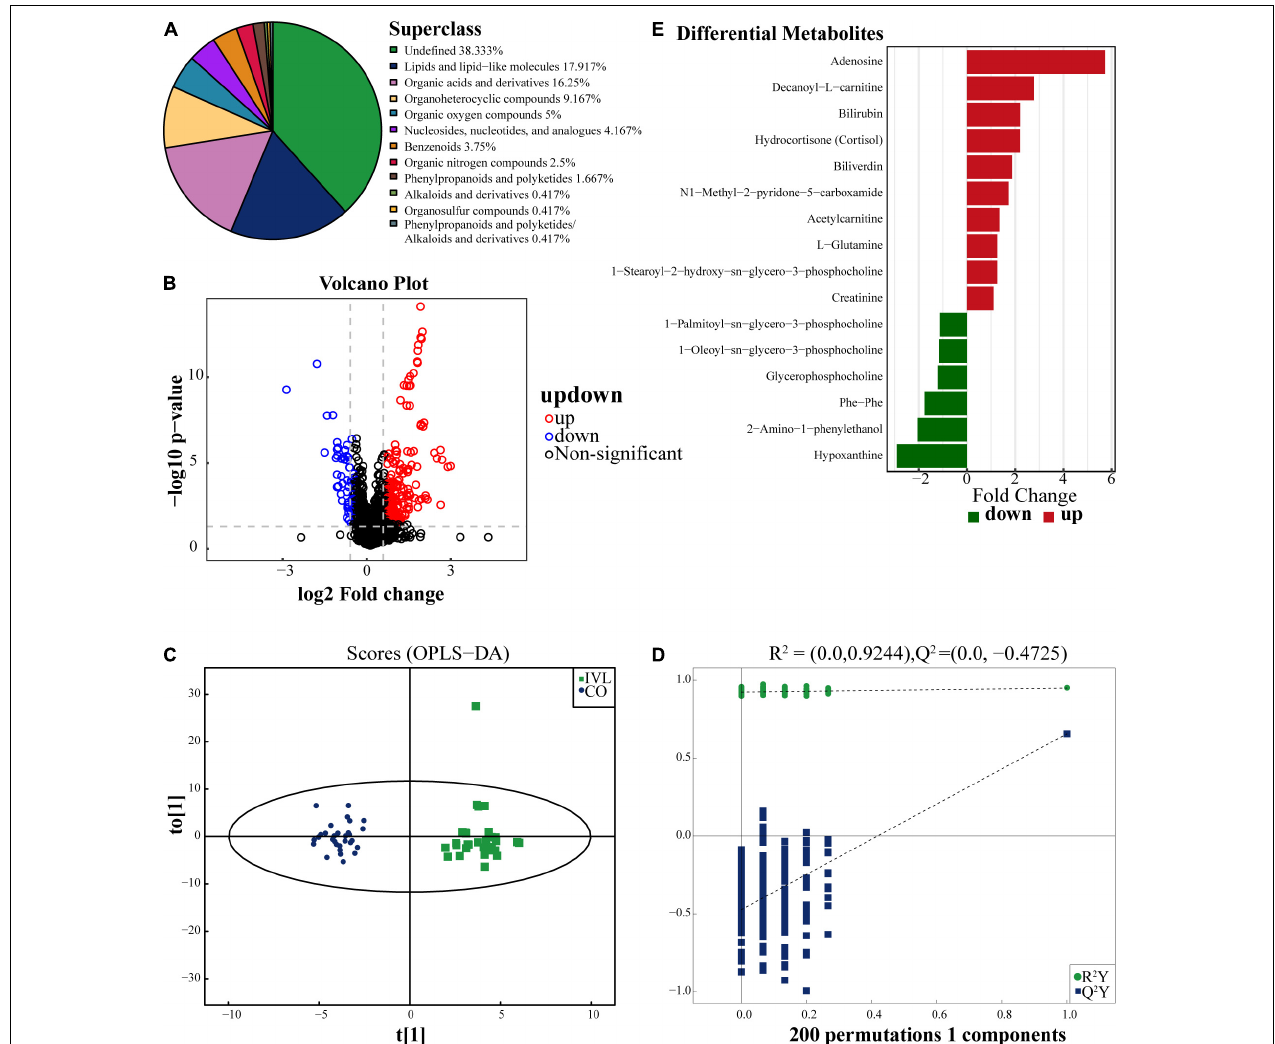
FIGURE 1 | Identification of differentially expressed metabolites. (A) The pie chart displayed all the metabolites identified in this project in either positive or negative ion modes, and their chemical attribution. (B) Volcano diagram revealed the changes between the IVL group and the healthy subjects. The red dots on the right side of the figure represented the upregulated metabolites, the blue dots on the left side meant the downregulated metabolite, and the black dots referred to non-significant difference. X -axis corresponded to log2 fold change and y -axis corresponded to –log10 P -value. (C) Score plot of OPLS-DA for IVL and control groups, indicating the separation degree between the two groups. (D) A permutation test conducted with 200 randomly initiated permutations in an OPLS-DA model by cross-validation. T[1] referred to principal component 1, to[1] represented principal component 2, and the ellipse was 95% confidence interval. The dots in the same color meant each biological repetition within the group, and the distribution state of the dots reflected the degree of difference between groups and within groups. (E) The bar chart displayed 16 significant metabolites between IVL patients and control group (VIP > 1, P < 0.05). The x -axis represented the fold change of differential expression of these